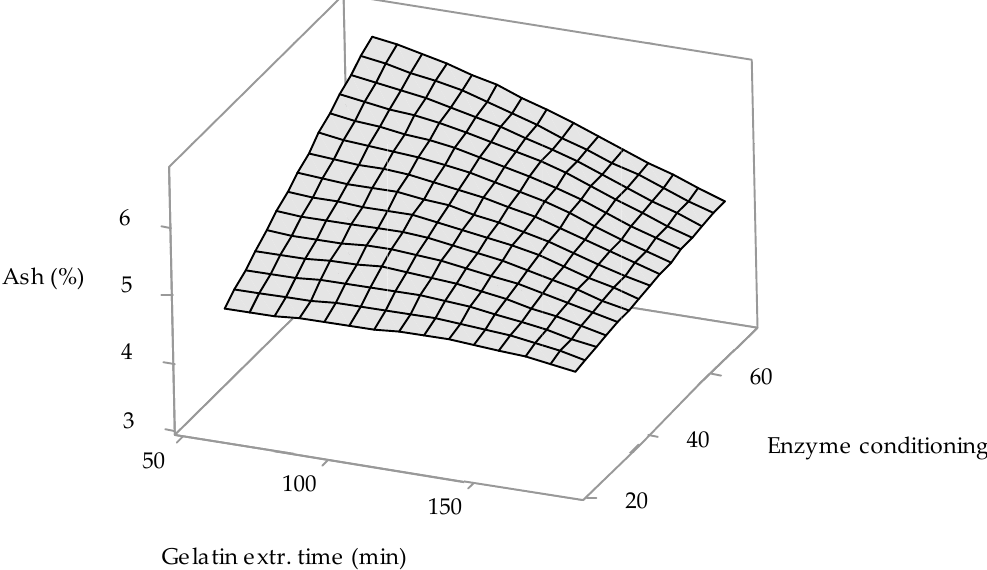
Figure 4. The influence of the gelatin extraction time and enzyme conditioning time on the gelatin ash content.